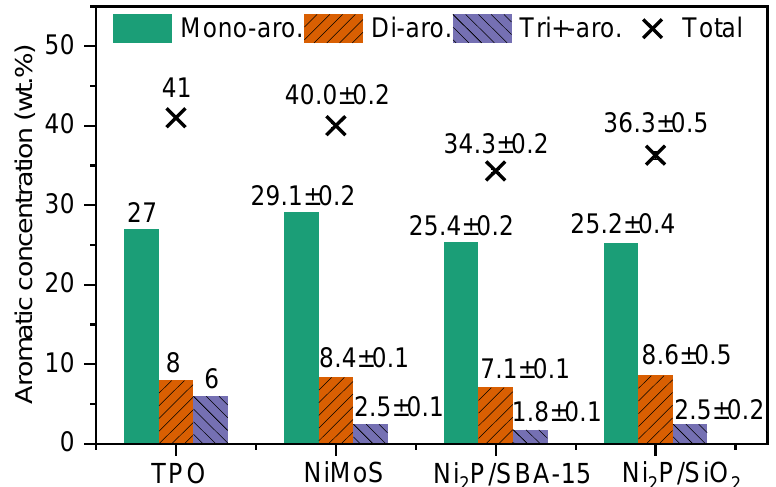
Figure 6. Aromatic compound distributions on NiMoS, Ni 2 P/SBA-15 and Ni 2 P/SiO 2 catalysts at 3.0MPa, 350 ◦ C, LHSV of 0.5 h − 1 , and time on stream of 12 h.